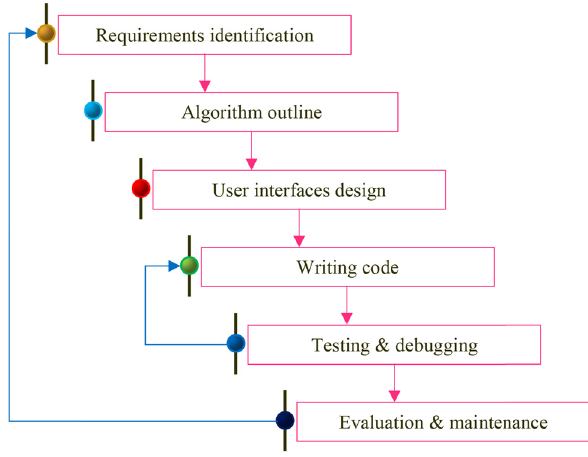
Figure 7: Schematic diagram of developed tool life cycle.